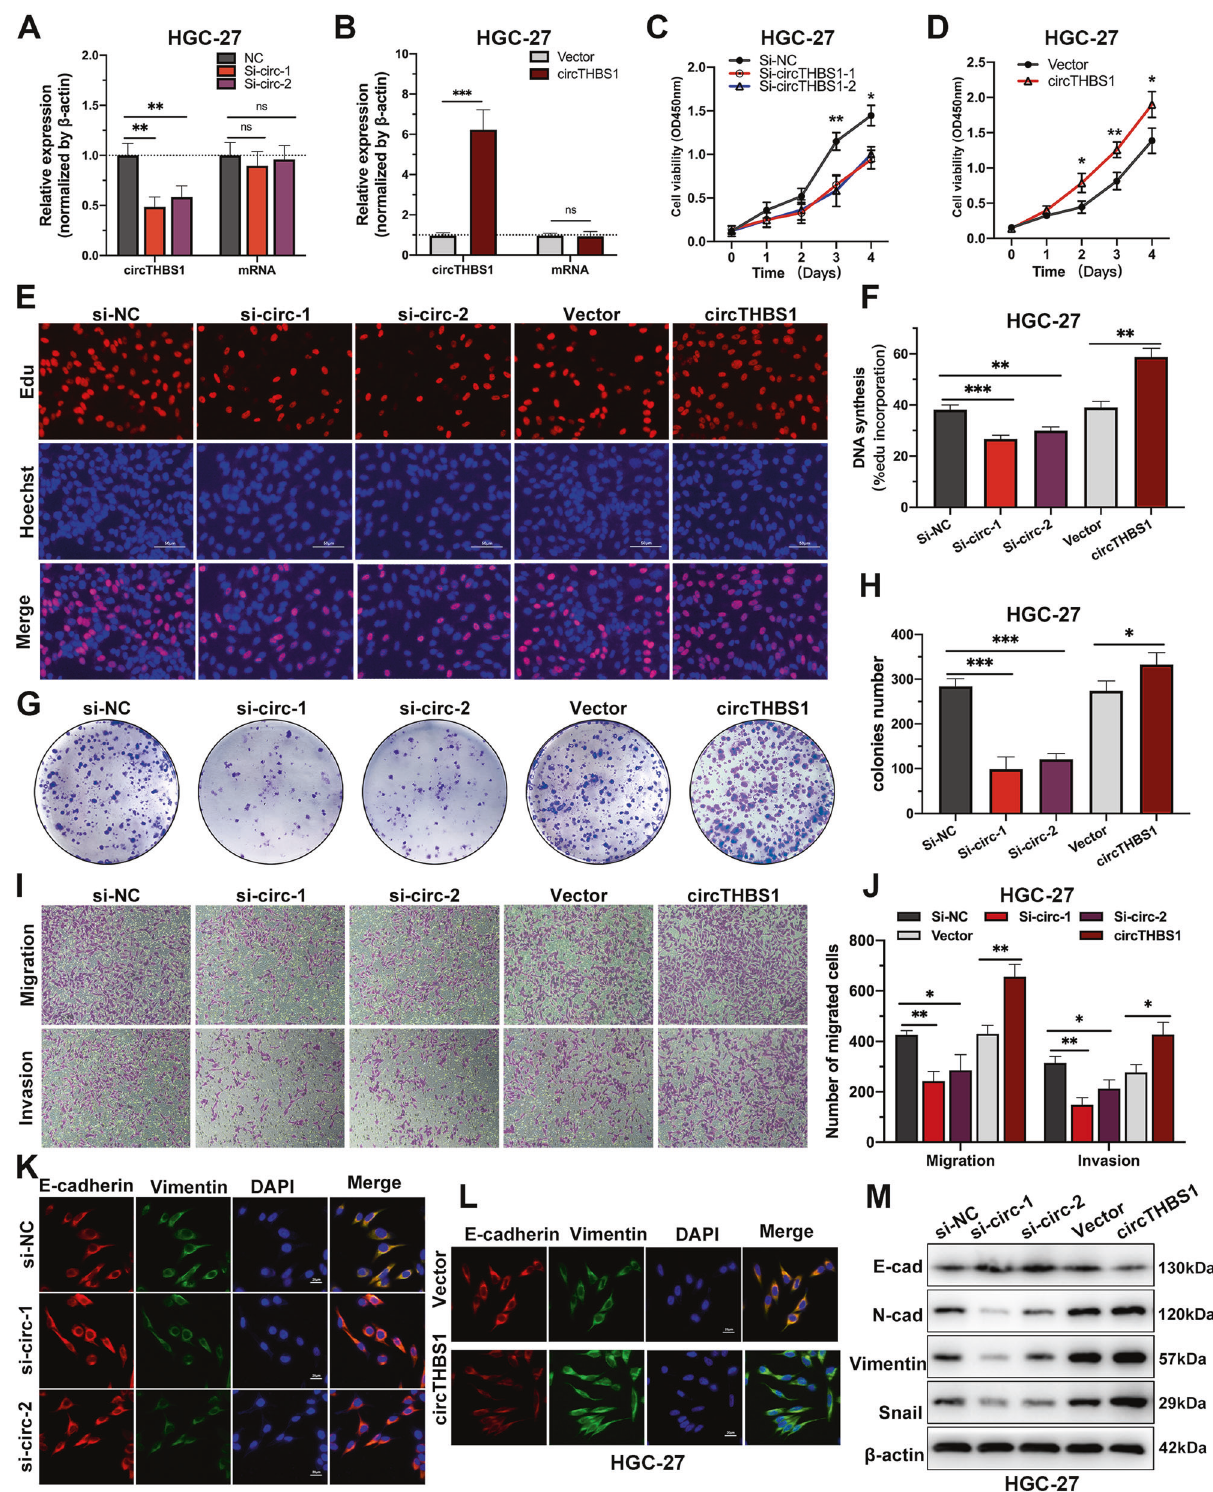
Fig. 2 CircTHBS1 promotes GC cells proliferation, migration, and invasion in vitro. A, B The relative expression of circTHBS1 and THBS1 mRNA in AGS and HGC-27 cells transfected with circTHBS1 overexpression plasmids or siRNA. C, D The growth curves of HGC-27 cells evaluated by CCK-8 assays after knockdown or overexpression of circTHBS1. E , F The Effect of circTHBS1 on the proliferation of HGC-27 cells detected by EdU assays. Scale bar = 50 μ m. G , H Colony formation assay were used to detect the effect of circTHBS1 expression on the proliferation of HGC-27 cells. I, J Transwell assays in HGC-27 cells with knockdown or overexpression of circTHBS1 to detect migration and invasion ability. K, L The expression of E-cadherin (red) and vimentin (green) in HGC-27 cells detected by immuno fl uorescence staining, and DAPI (blue) was applied for nuclear staining. Original magni fi cation, 400×; scale bar = 20 μ m. M Expression of EMT-related proteins in HGC-27 cells were detected by Western blot; β -actin was used as an internal control. Quantitative data presented as the mean ± SD. * P < 0.05, ** P < 0.01, *** P < 0.001 (Student ’ s t -test).